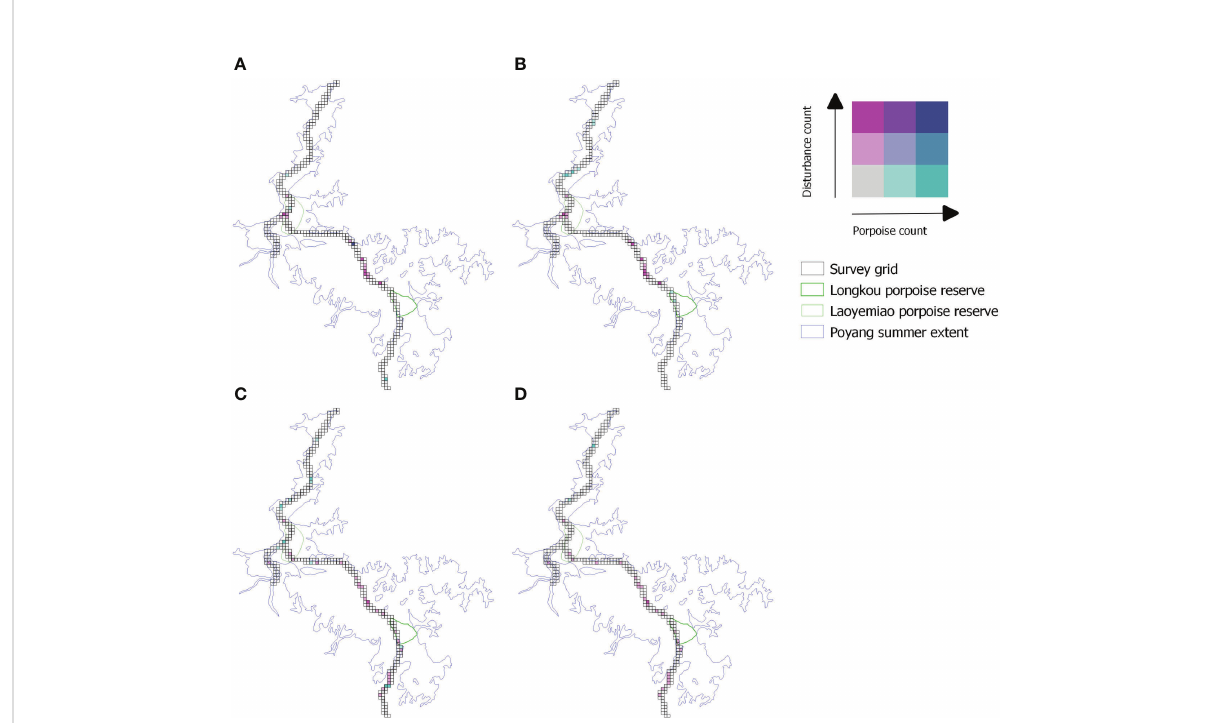
FIGURE 4 Bivariate plots of porpoise and threat counts: (A) porpoises versus fi shing vessels (summer); (B) porpoises versus sand-mining vessels (summer); (C) porpoises versus fi shing vessels (winter); (D) porpoises versus sand-mining vessels